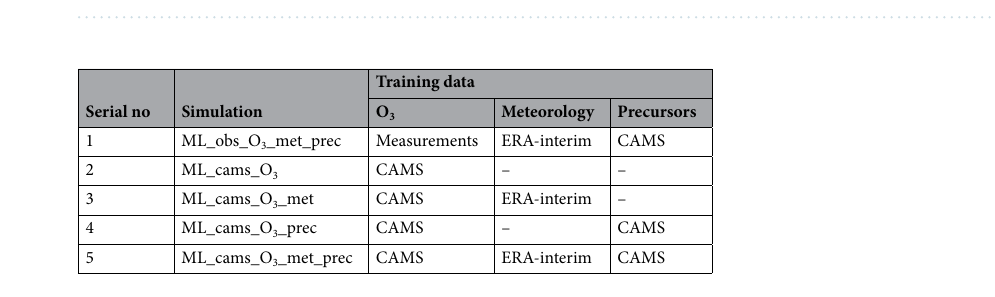
Table 1. Different ML model simulations performed in the study.